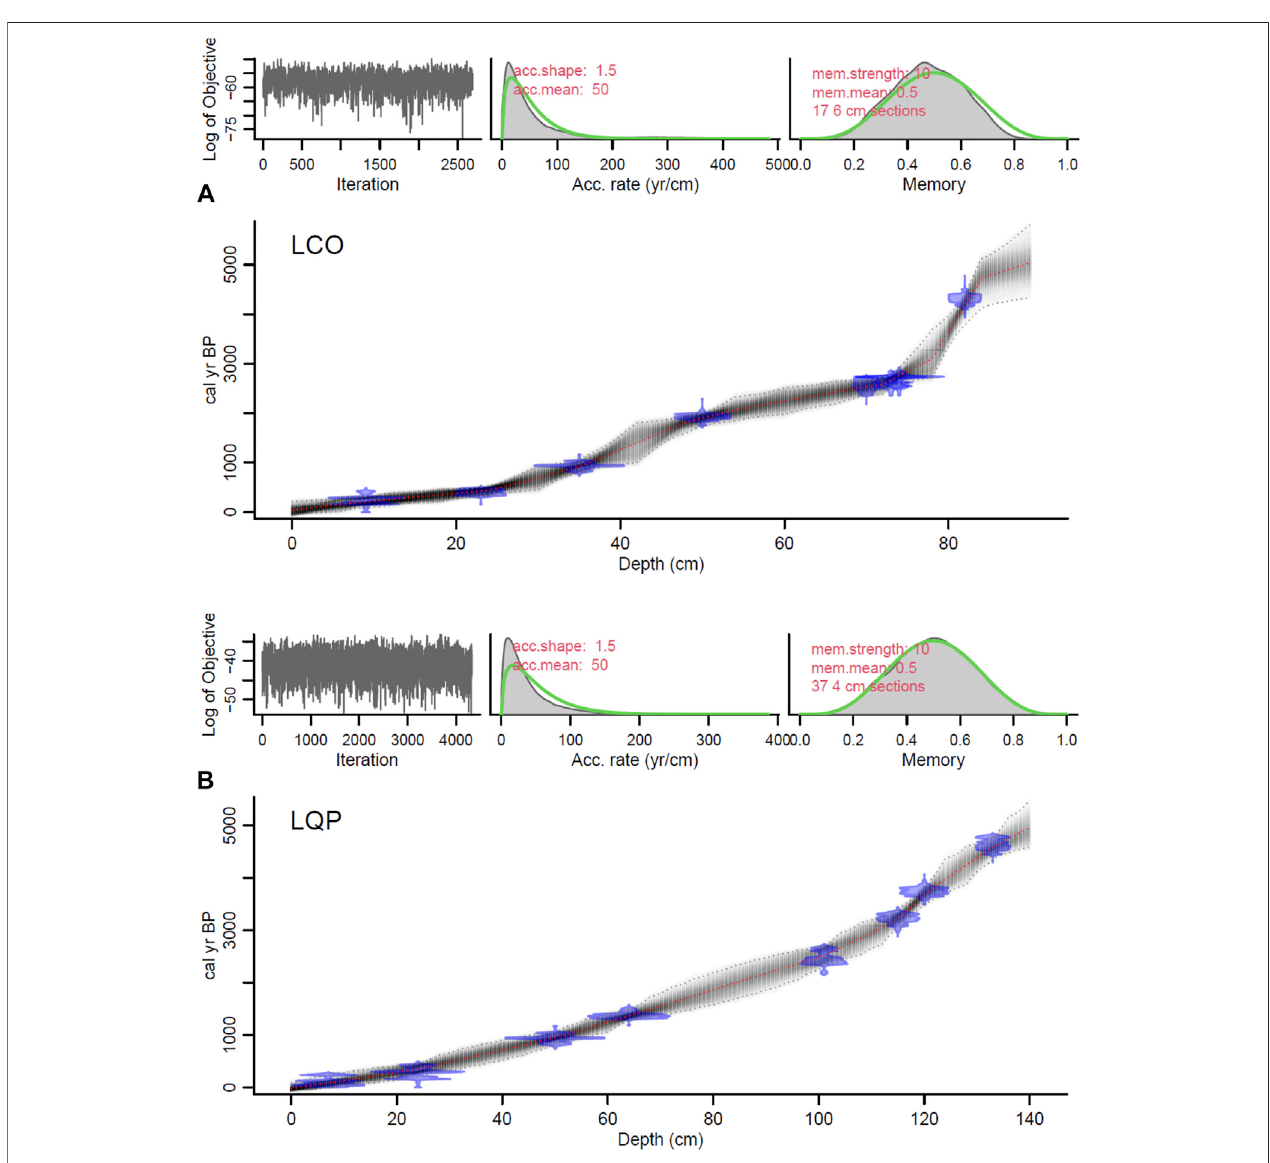
FIGURE 3 | Age – depth model of the core of (A) Laguna Corralito (LCO) and (B) Laguna Quebrada Parada (LQP). The top panels show, from left to right, Markov chain Monte Carlo iteration, prior (green curves)/posterior (gray histograms) distributions of the accumulation rate and memory of LCO and LQP. In the main panel, calibratedradiocarbonagesareshowninblue,andtheage – depthmodelisrepresentedbythegraydots,withadarkergrayindicatingmoreprobablecalendarages.The gray dotted lines show 95% con fi dence intervals, and the red curve indicates the best model that was used for the study of both